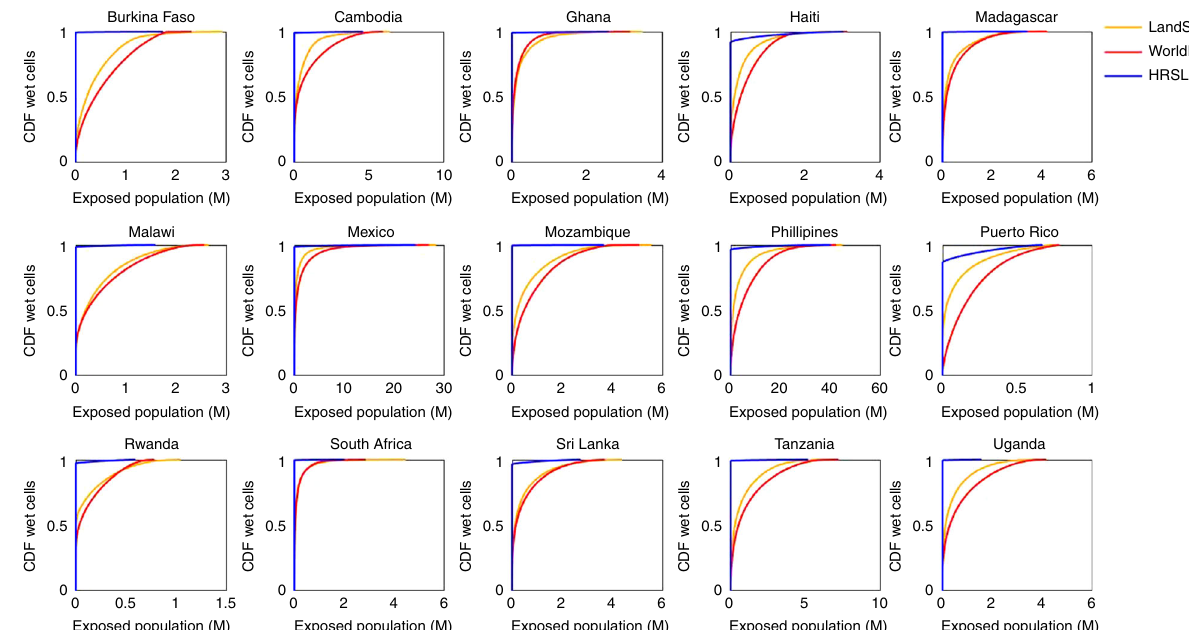
Fig. 1 Distribution of exposed population. Cumulative distribution of the population living in the 1 in 100 year fl oodplain distributed across all the modelled fl oodplain cells. Red indicates WorldPop exposure, Yellow the LandScan ™ exposure, and Blue the exposure calculated using the HRSL